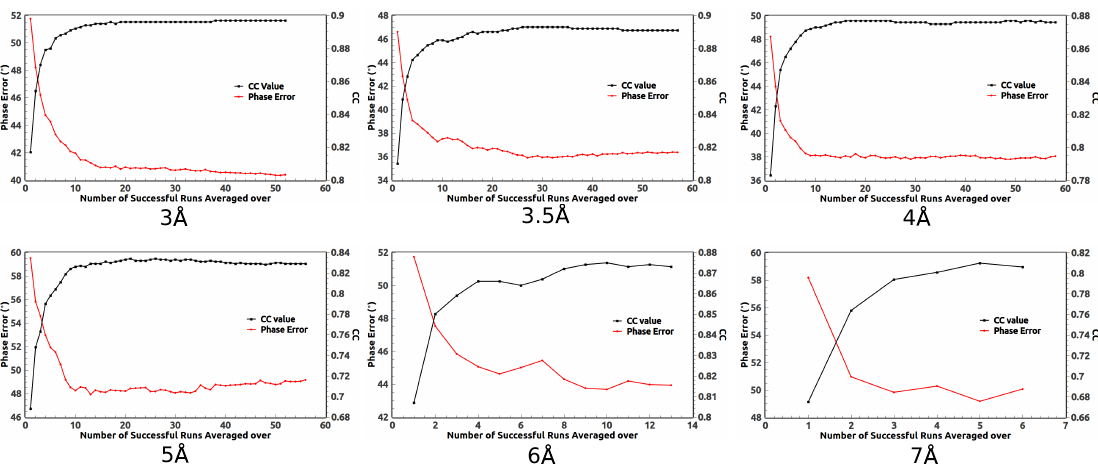
Figure 5. After averaging over those successful runs presented in Figure 4, the phase errors further decrease by about 10 ◦ and the CC values further increase by about